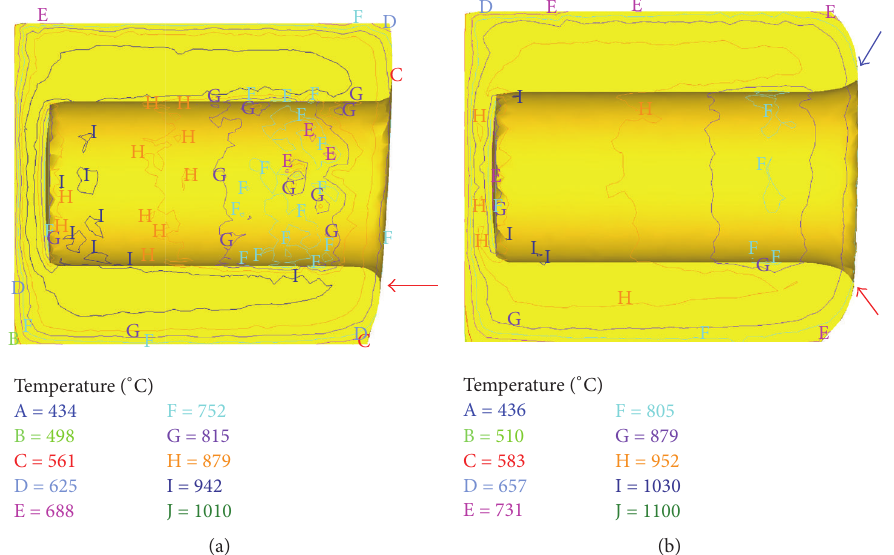
Figure 13: Effect of friction on the temperature distribution of billet at the piercing speed of 100mm/s with friction coefficient of (a) 0.5 and (b) 0.7.